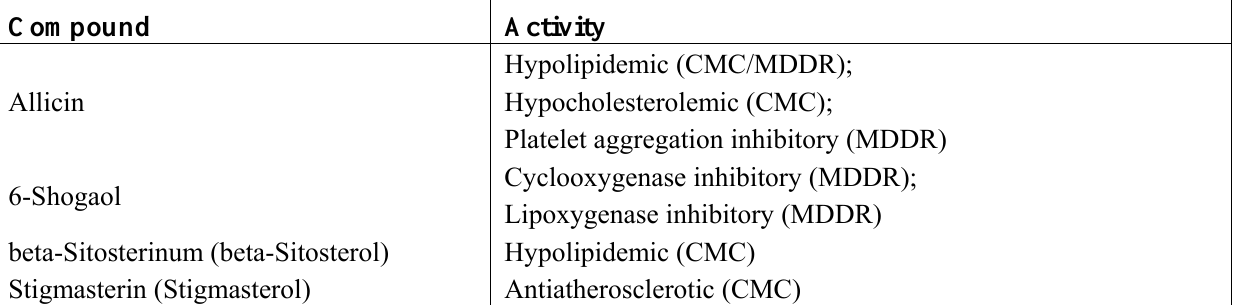
Table 2 . CMC- and MDDR-documented vegetable and legume functional components associated with ameliorating type 2